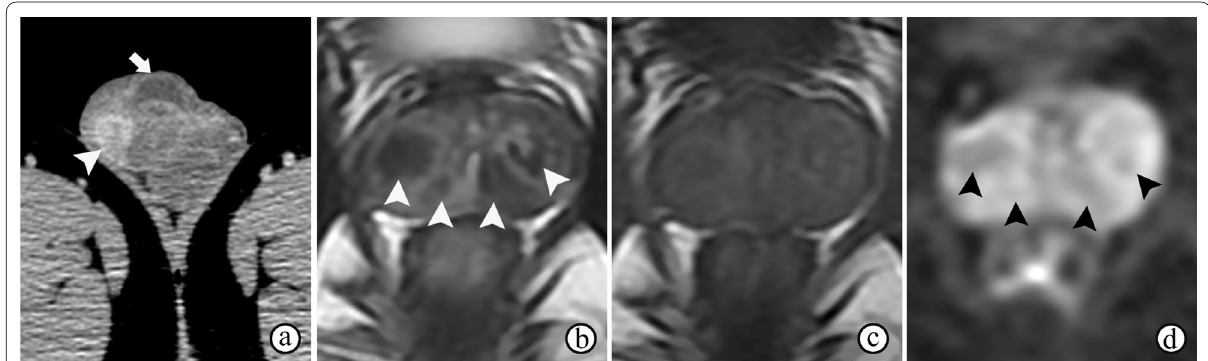
Fig. 6 Genitourinary tuberculosis in a 26-year-old man with a right scrotal skin ulceration accompanied by pus discharge and a strongly positive tuberculin skin test. a Computed tomography image shows an enhanced nodule in the right epididymis (arrowhead) with testicular hydrocele (arrow). b T2WI shows prostate atrophy and multiple extremely hypointense nodules inside the tissue (arrowheads). c T2WI shows slightly inhomogeneous signal intensity of the prostate. d DWI at a b-value of 800 s/mm 2 shows slight hypointensity of the nodules